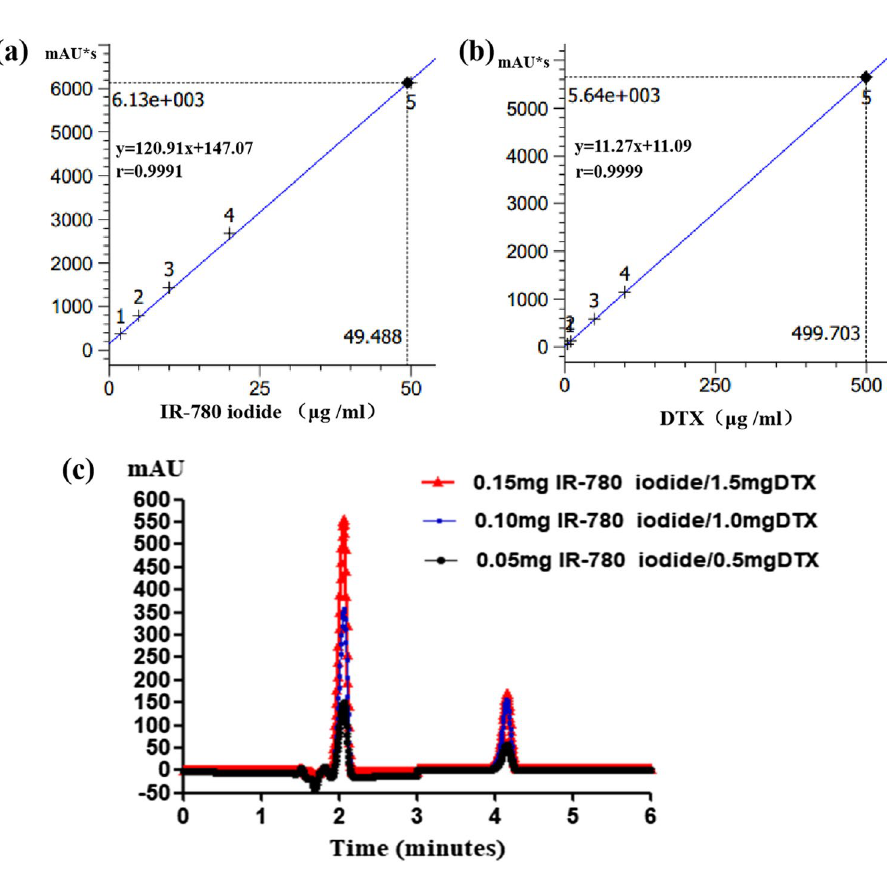
Figure 2. The entrapment of IR-780 iodide and DTX in IR780-NBs-DTX with different initial doses. ( a , b ) The standard curves of IR-780 iodide and DTX obtained via HPLC. ( c ) The signal intensity of IR-780 iodide at 2.1 min and that of DTX at 4.1 min with different initial doses via